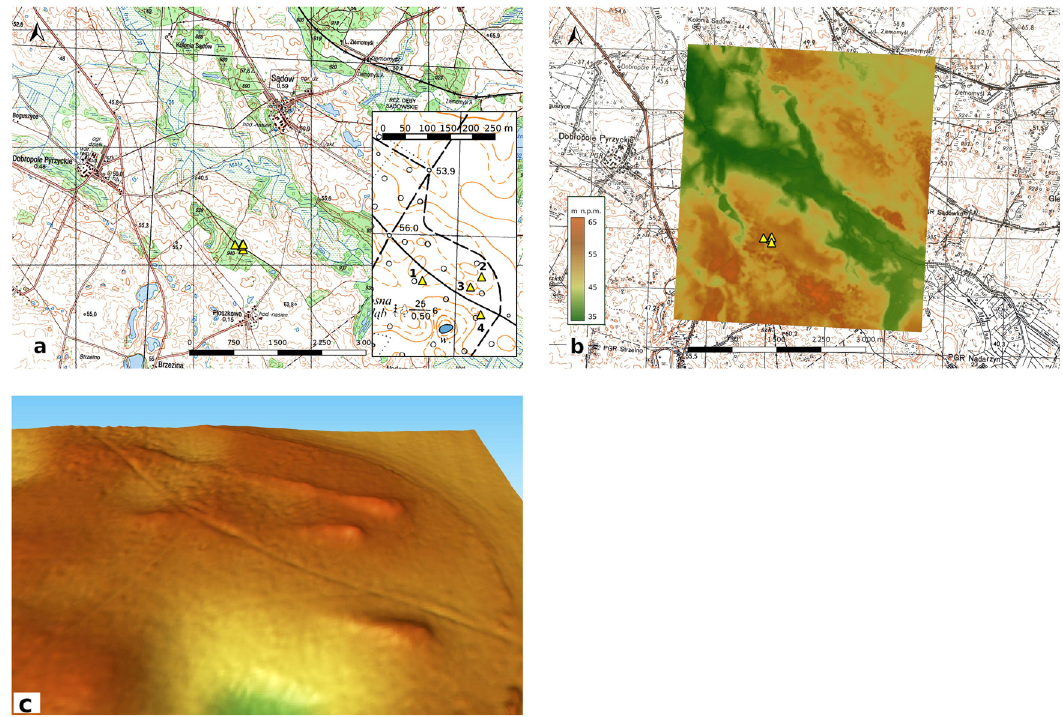
Figure 21: The P ł oszkowo megalithic group ( a ) . The group is shown on a hypsometric map fragment ( b ) and its digital terrain model in hypsometric colours ( c ) ( M. Schiller )